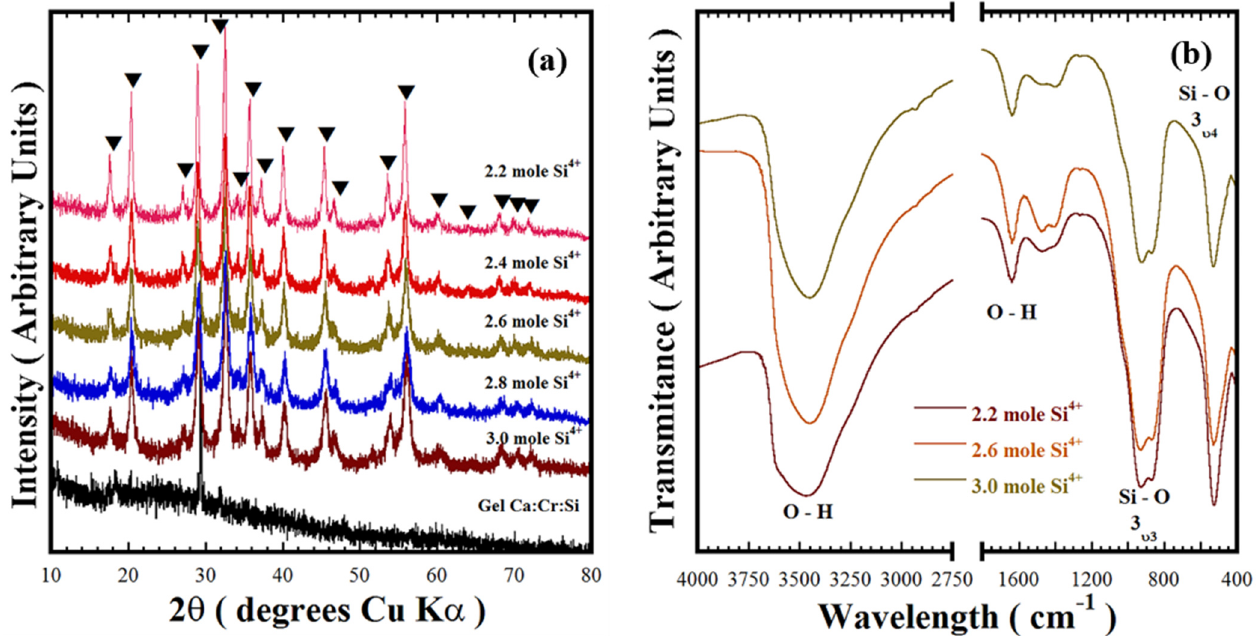
Figure 4. ( a ) XRD patterns and ( b ) FT-IR spectrum of the residual powders produced at 220 °C for 12 h without stirring in the 5.0 M KOH solvent (12.5 mL) using different Si 4+ precursor molar contents. Crystalline phases ( (cid:72) ) Ca 3 Cr 2 Si 3 O 12 uvarovite structure, COD Card No. 96-900-7150.